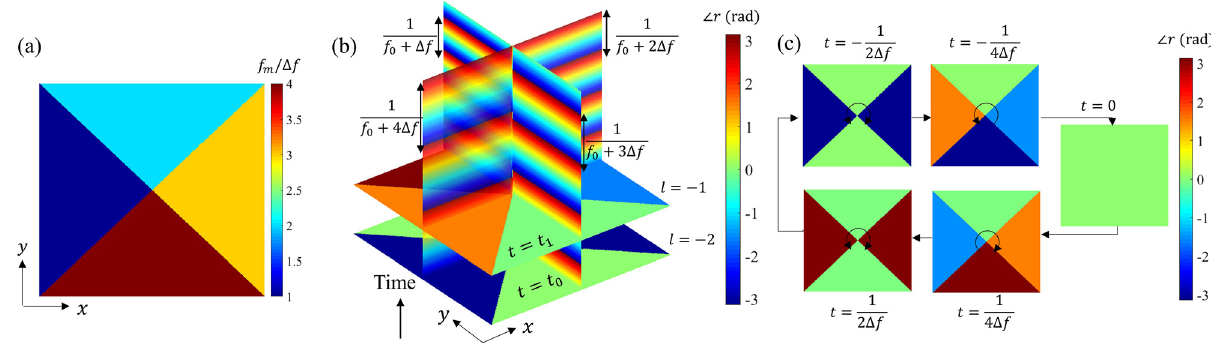
Figure 2: (a) Aperture of a TMM azimuthally divided into four equal sub-apertures with a modulation frequency offset of ​ Δ f . (b) The wavefront of re fl ected fi elds from the sub-aperture depicted as plane waves propagating in time. The transverse planes show the variation of azimuthal phase pro fi le across the aperture as a function of time. (c) The azimuthal phase pro fi le of the re fl ected light across the aperture at different instants of